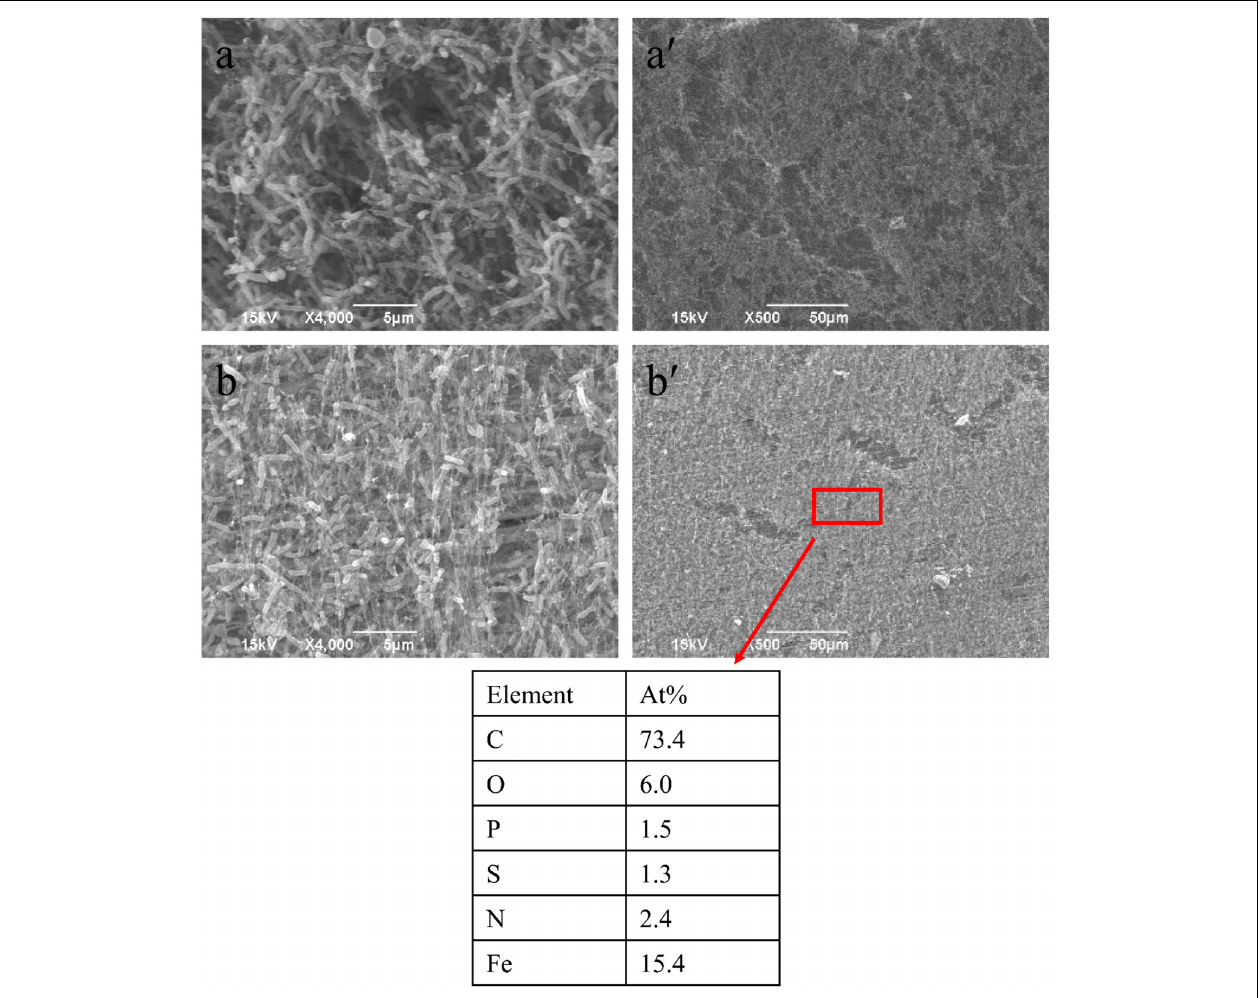
FIGURE 2 | . Biofilm SEM images of 304 SS exposed to Pseudomonas aeruginosa for 7 days (a,a (cid:48) ) and 14 days (b,b (cid:48) )